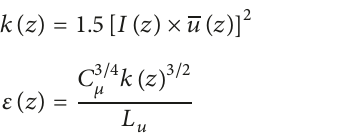
Figure 3: Grids on the surfaces of the buildings.